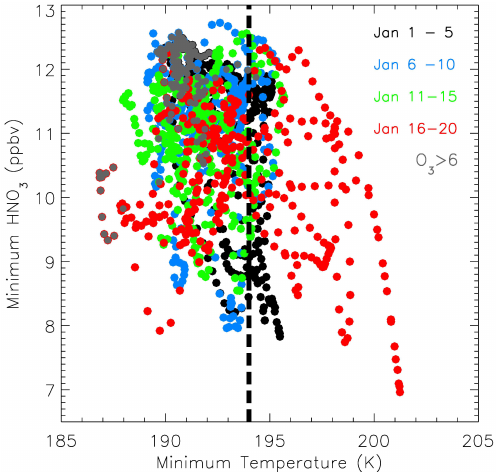
Figure 13. Scatterplot of minimum values of HNO 3 vs. minimum values of temperature for the domain of 70 ◦ N to the pole at 550K for the period of 1–20 January (from Fig. 11); the vertical dashed line denotes 194K. Colors correspond to data values in each of the separate 5-day periods. Points having corresponding values of ozone >6ppmv are shown in gray. Figure 14. Contour plots of the frequency distributions of points